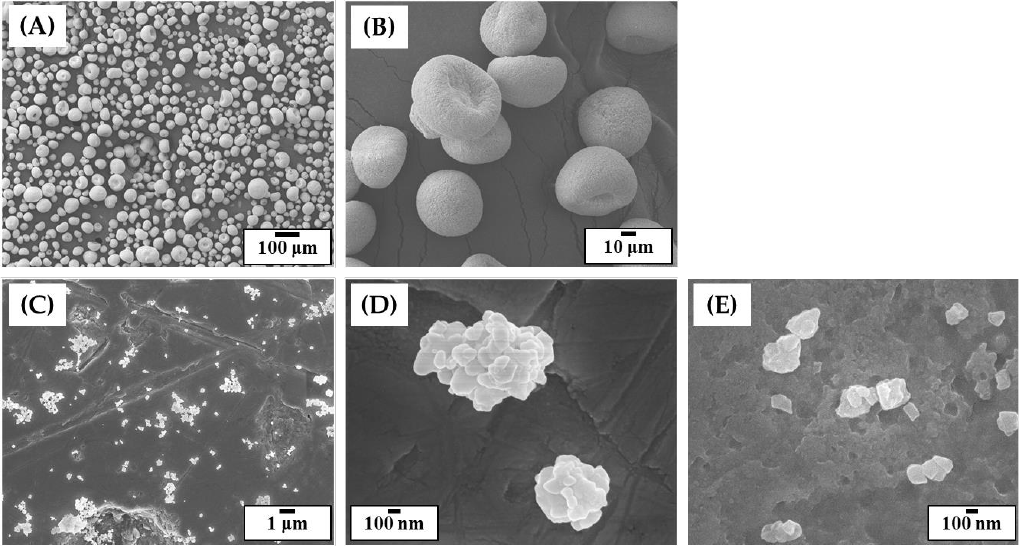
Figure 4. Representative FE-SEM images showing as-received 5Y-PSZ granules ( A ), granules calcined at 1000 °C ( B ), crushed particles obtained after ball-milling of granules calcined at 1000 °C ( C , D ), and crushed particles obtained after ball-milling of granules calcined at 500 °C ( E ).